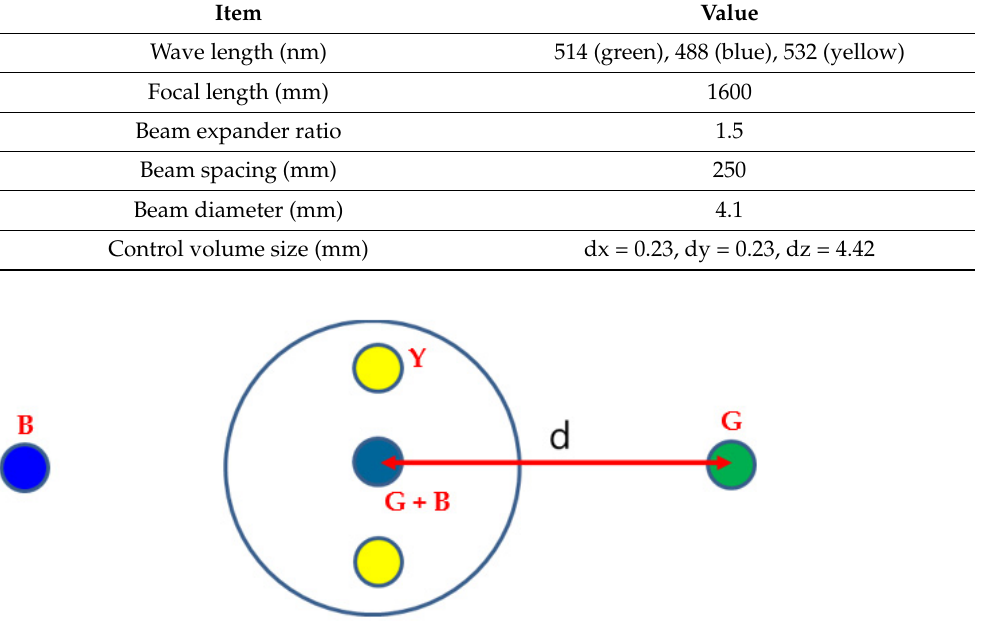
Figure 4. Tunnel’s test section and conventional LDV probe configuration (looking downstream). Table 1. Specification of the 3-D LDV system.